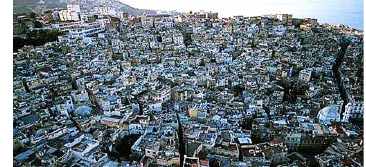
Figure 8. General view of the Kasbah of Algiers 35